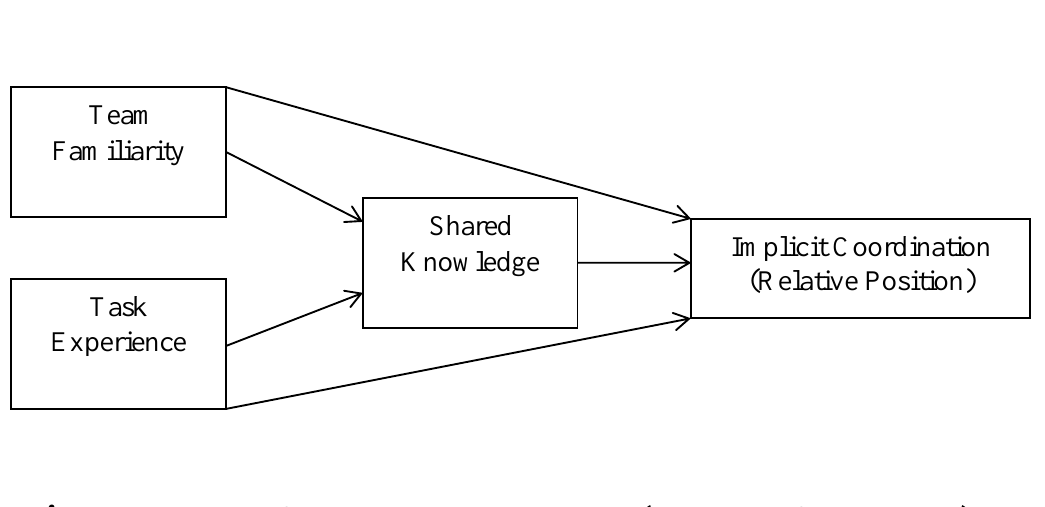
Figure 3.2 - Model of Implicit Team Coordination (Blickensderfer et al.